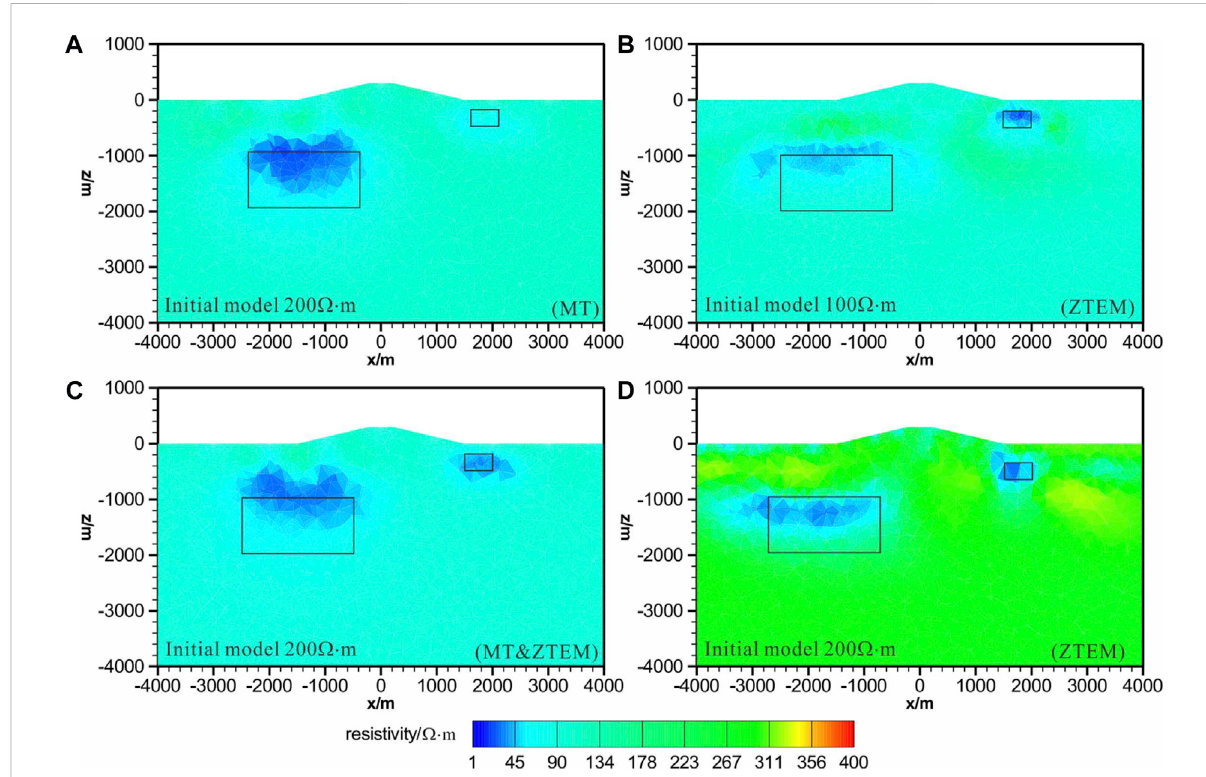
FIGURE 4 Inversion results for the synthetic model with topography at the xz section for y =0 m. (A,D) and (C) are the MT inversion, ZTEM inversion, and joint MT and ZTEM inversion with initial model and a 200 Ω · m half-space, respectively. (B) is the ZTEM inversion with a 100 Ω · m